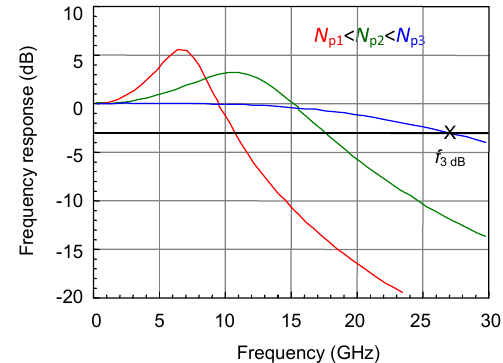
Fig. 1 | Schematic plot of intrinsic modulation response with increasing photon densities